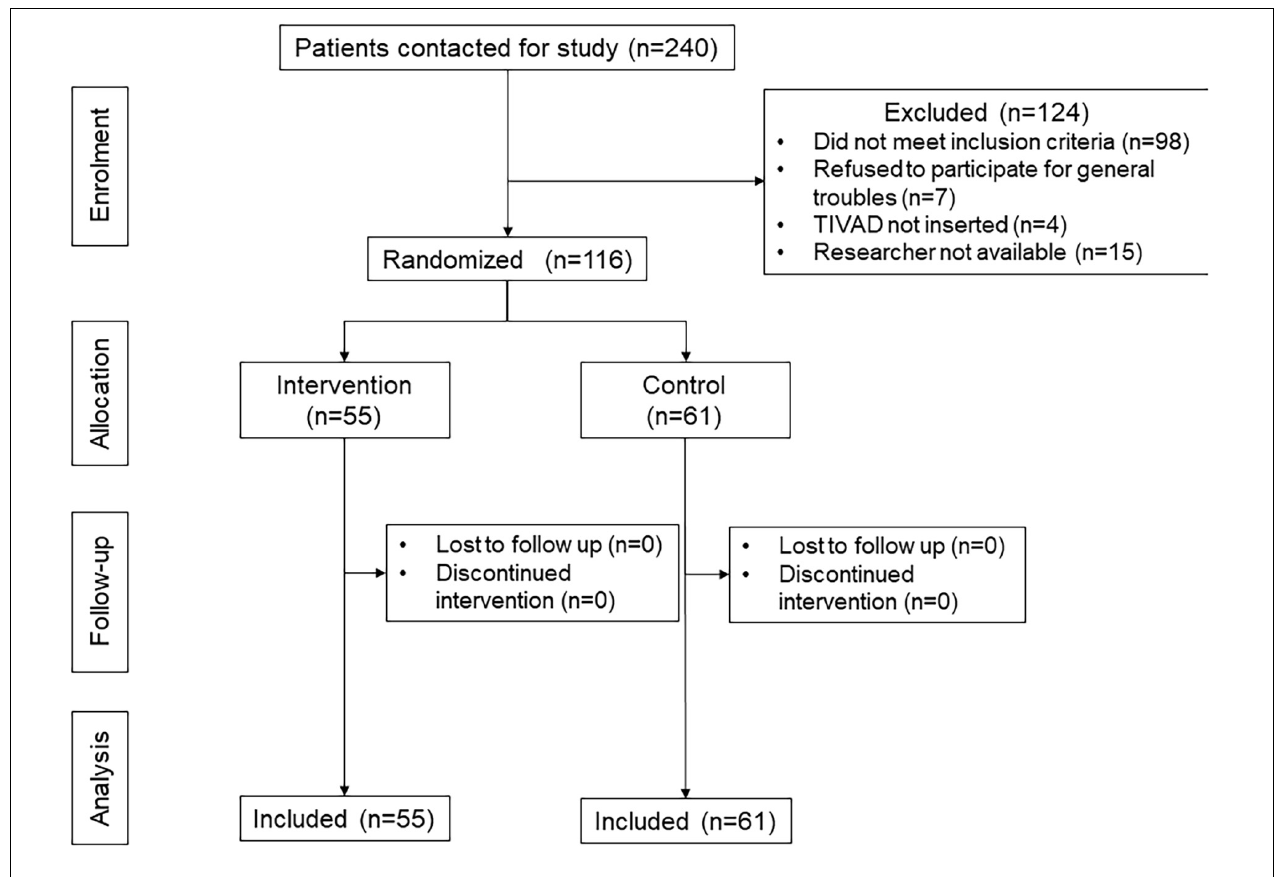
FIGURE 2 | Flowchart of patient inclusion. TABLE 1 | Patient